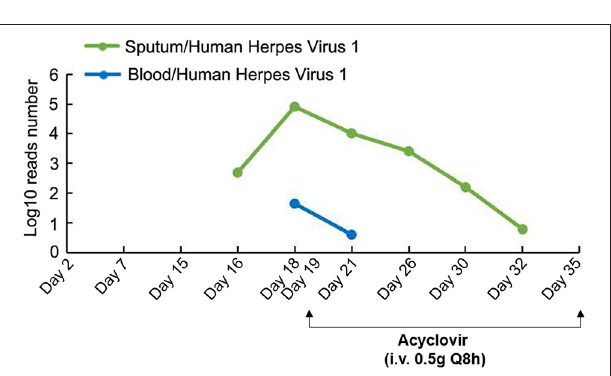
FIGURE 3 | mNGS detection and anti HHV-1 therapy. Acyclovir: 0.5g intravenous every 8h from Day 19 to Day